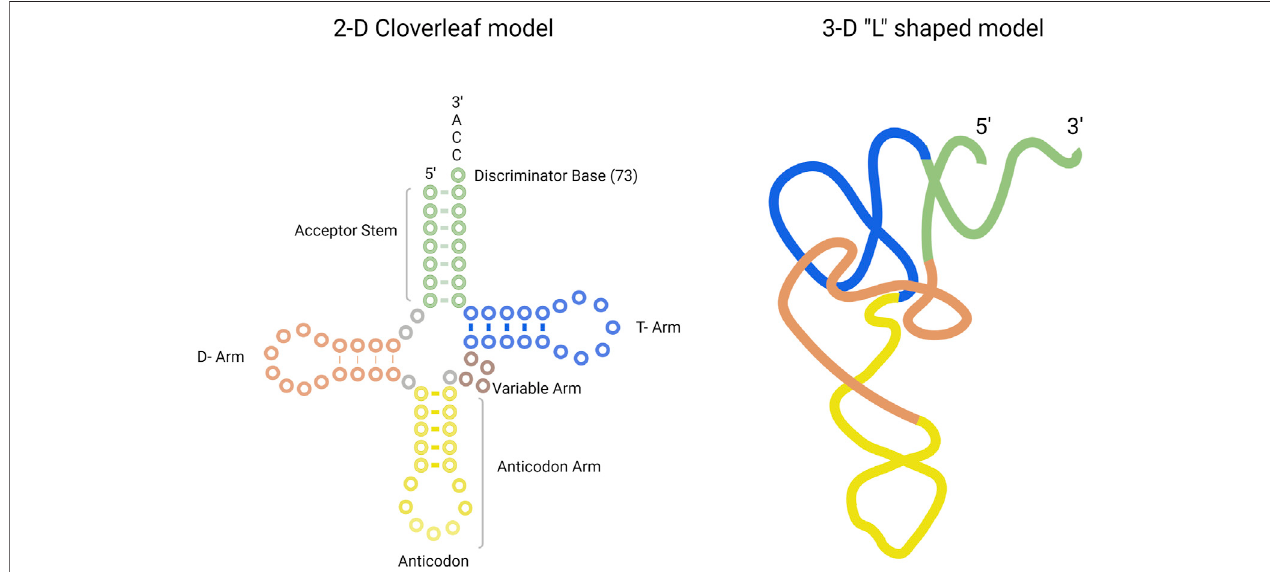
FIGURE 1 | Structure of tRNA presented in the 2-D cloverleaf model (left) and in the 3-D “ L ” shaped model (right). The tRNA consists of acceptor stem (green), T-arm (blue), D-arm (orange), anticodon arm (yellow), and variable arm (purple).